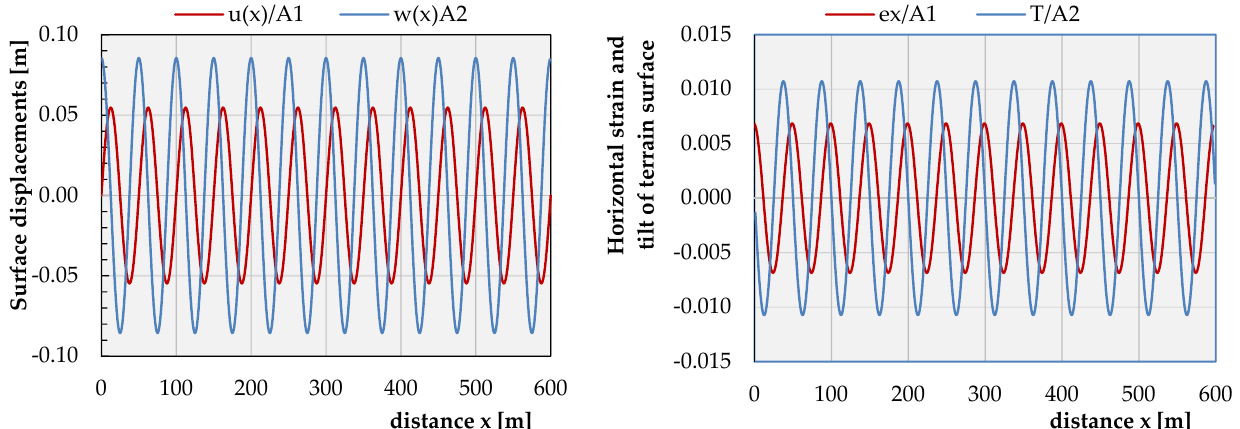
Figure 8. Instantaneous amplitudes of the surface vibration induced by the R-wave ( left ) and instantaneous amplitudes of the surface horizontal strain and the surface rotation around the y-axis ( right ).